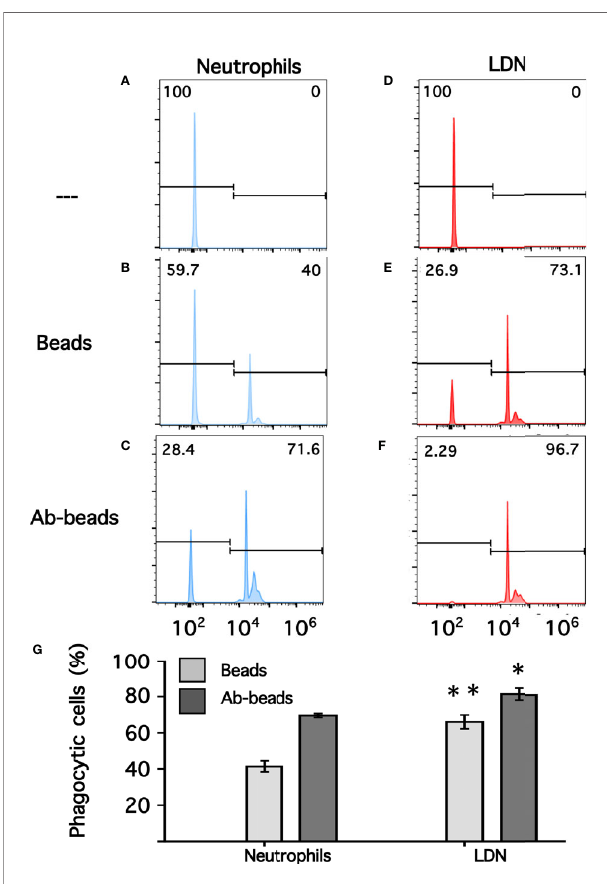
FIGURE 8 | Phagocytosis by neutrophils and by low-density neutrophils. Neutrophils (A – C) or low-density neutrophils (LDN) (D – F) were left alone ( — ) or mixed with fl uorescent non-opsonized latex beads (Beads), or with fl uorescent antibody-opsonized latex beads (Ab-beads) and then incubated for 30 min at 37°C to assess phagocytosis. Increased fl uorescence of cells represents ingested beads (phagocytosis). Histograms (blue for neutrophils, and red for LDN) are representative of 4 experiments with similar results. Graph (G) shows the percentage of phagocytic cells. Data are mean ± SEM of four independent experiments. Asterisks denote conditions that were statistically different between neutrophils and LDN. For non-opsonized beads (**p = 0.0024) and for antibody-opsonized beads (*p =